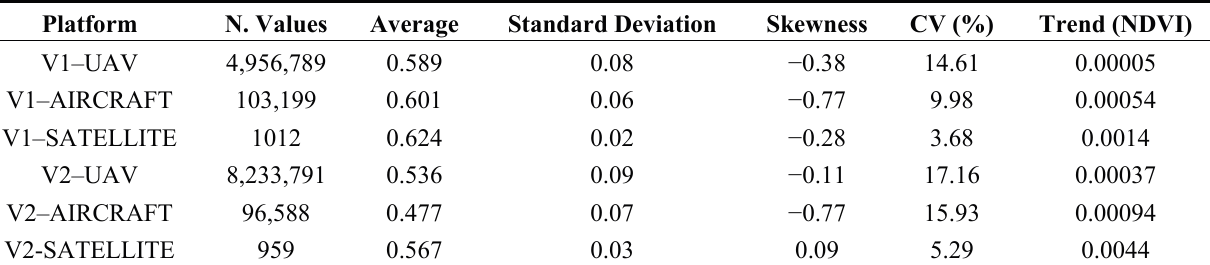
Table 2. Basic statistics at native